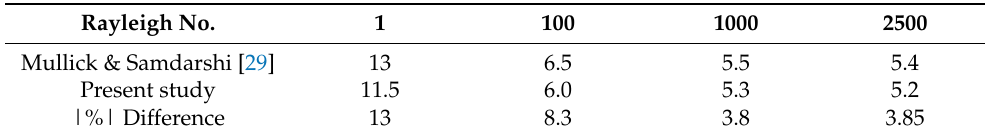
Table 5. Top heat loss coefficient comparison (Ut: W/m 2 /K).